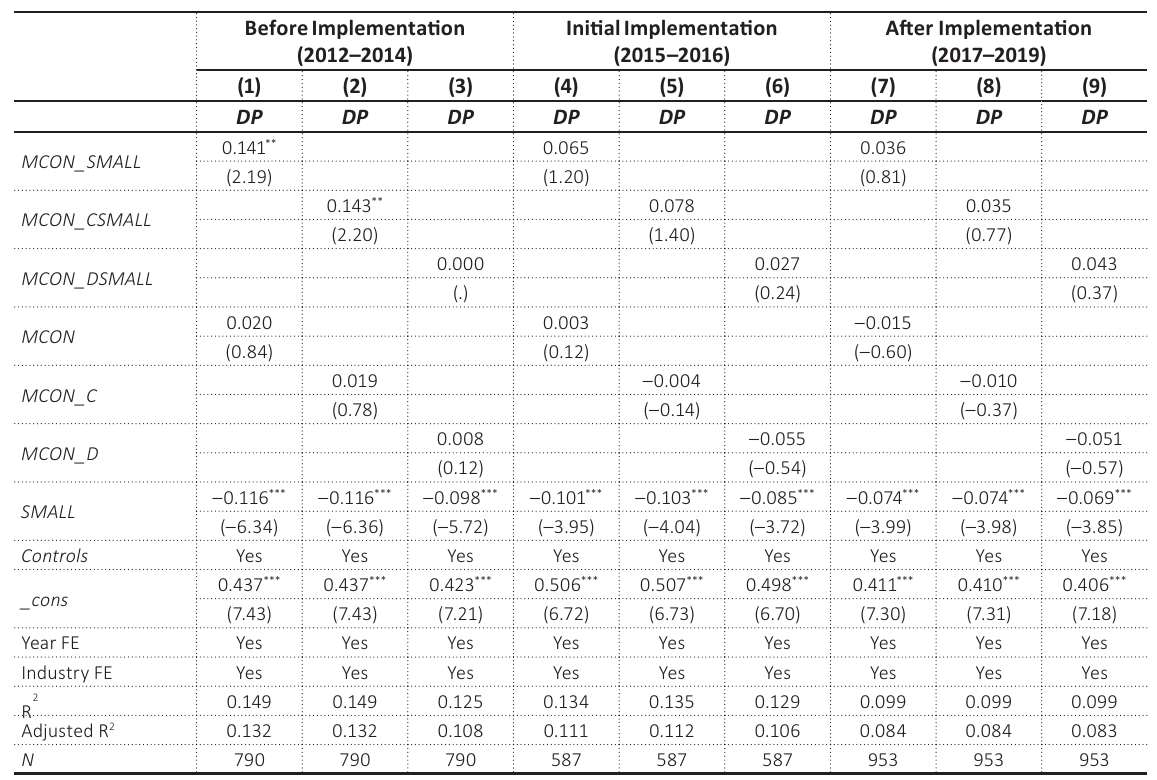
Table C1. Interacting role of firm size in the relationship between military-connected firms and